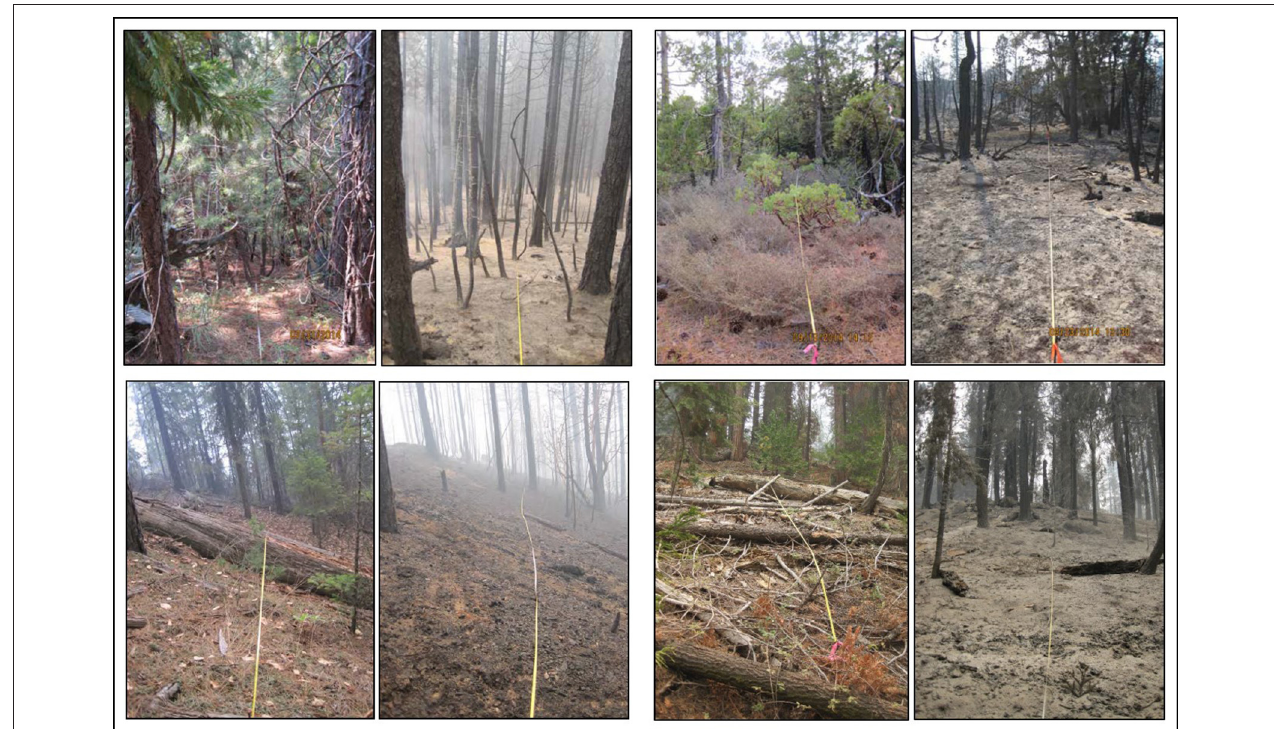
FIGURE 2 | Paired photos taken during pre-fire and post-fire measurements showing examples of fire impacts on forest vegetation and substrate at four plot locations used in this study. For each pair of photos, pre-fire conditions are shown on the left and post-fire conditions are shown on the right. Photo credit: Reiner and Ewell.